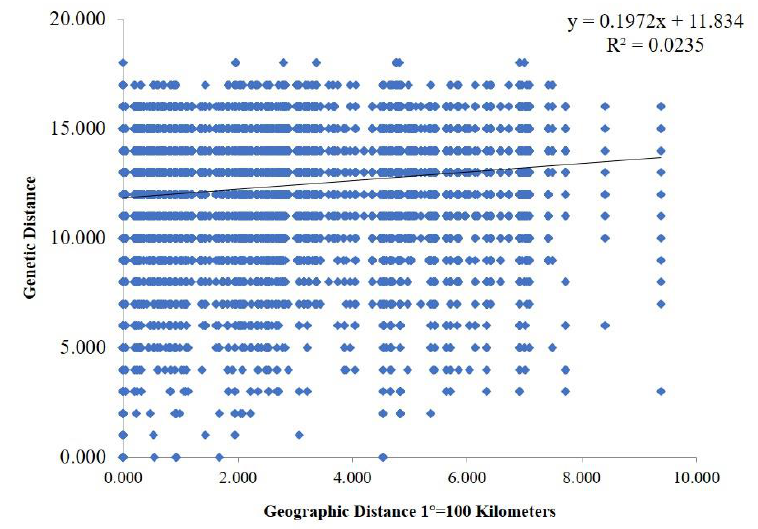
Figure 7. Mantel test between genetic distance and geographic distance. The geographic distance between different areas was calculated based on their corresponding longitude and